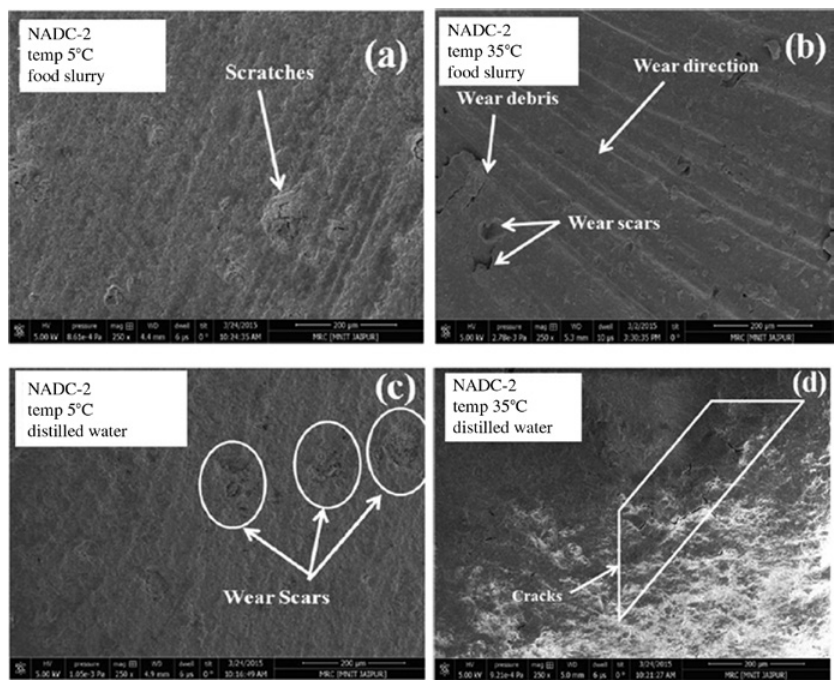
Figure 12: FE-SEM images of worn surfaces of composite filled with 2 wt.% nanoalumina under normal load of 40 N, chewing speed of 5 mm/s and varying chamber temperature of (a) 5 ° C, food slurry; (b) 35 ° C, food slurry; (c) 5 ° C, distilled water; and (d) 35 ° C, distilled